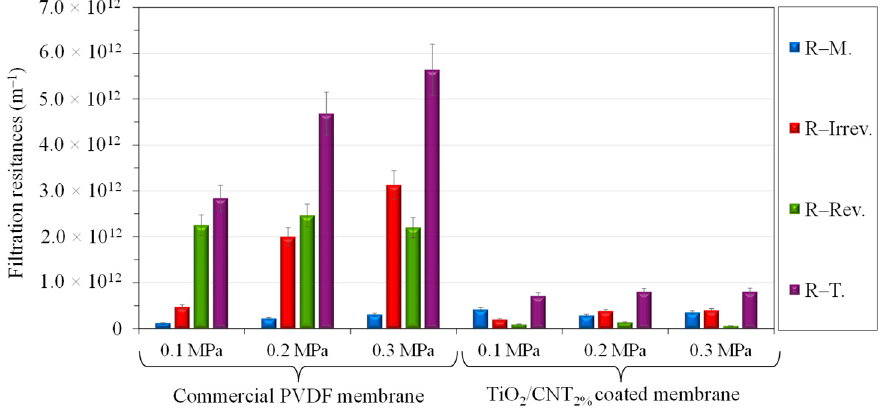
Figure 6. Effects of the transmembrane pressure on the filtration resistance for the commercial and TiO 2 /CNT 2% nanocomposite-modified membranes.